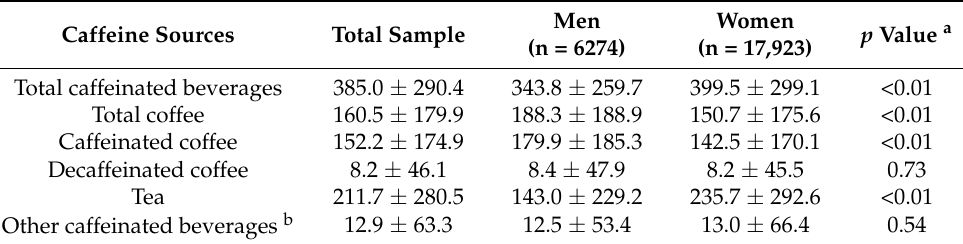
Table 2. Total daily consumption (mL/day) of various caffeinated beverages in the NutriNet-Sant é study (n = 24,197).